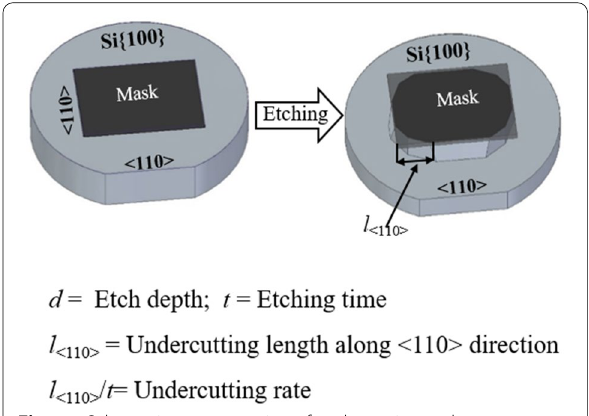
Fig. 51 Schematic representation of undercutting at the convex corners of a rectangular shape mask pattern with sides aligned along < 110 > directions which contain {111} planes